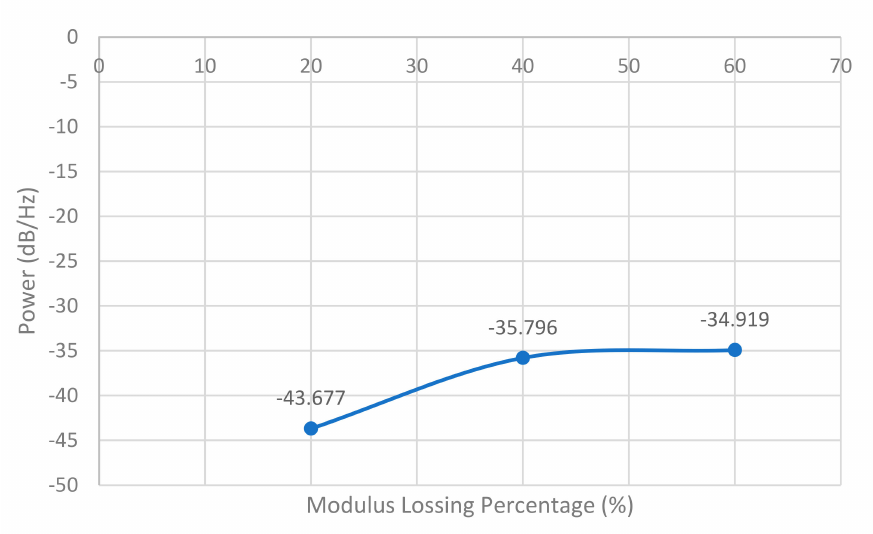
Figure 30. Average PSD energy over the damaged area (7.5 m to 7.6